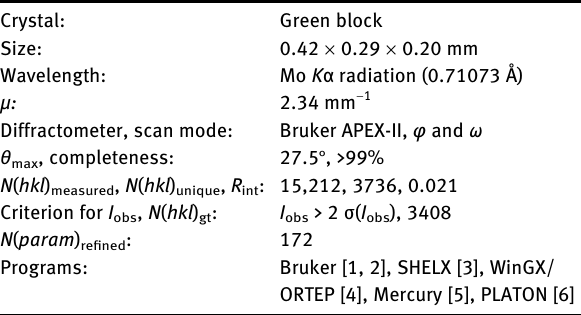
Table 1 contains crystallographic data and Table 2 contains